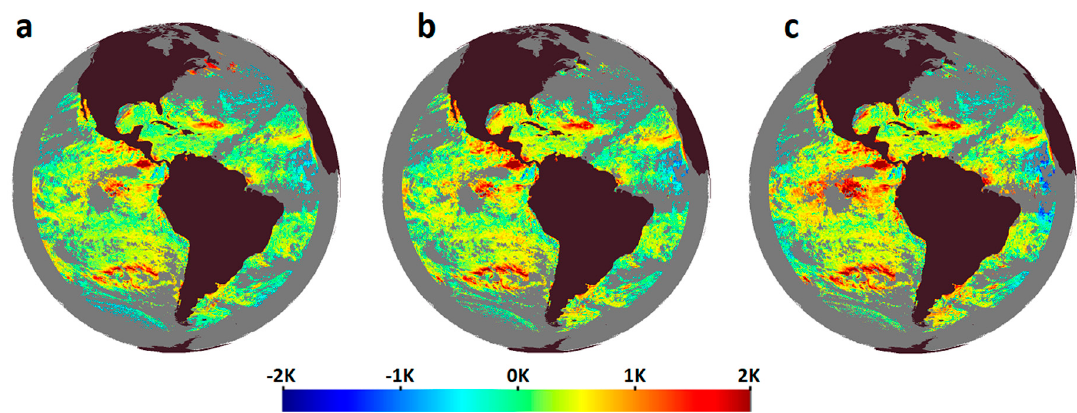
Figure 7. Images of the deviation of GOES-16 ABI SST from CMC for (a) GR-IS SST, (b) GR-L4 SST, and (c) PWR-L4 SST at 20:00 UTC 1 March 2018. Table 3. Statistics of sensitivities and deviations of ABI SST from CMC SST corresponding to the images in Figures 6 and